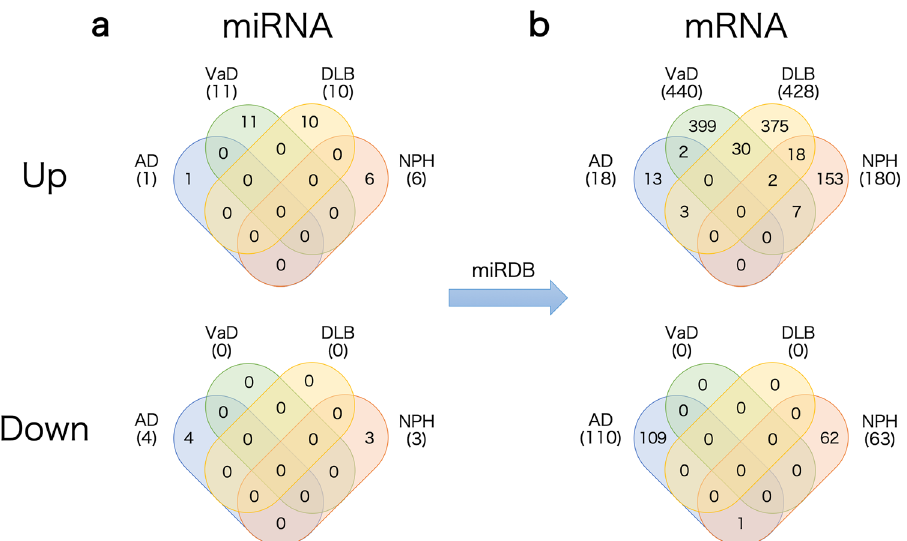
Figure 2. Effective miRNAs and genes used in our dementia-type prediction model. ( a ) The number of up- and down-regulated miRNAs used for the final models for each dementia subtype. ( b ) Target genes for each miRNA used for each model; the target genes were predicted by using annotation in the miRDB